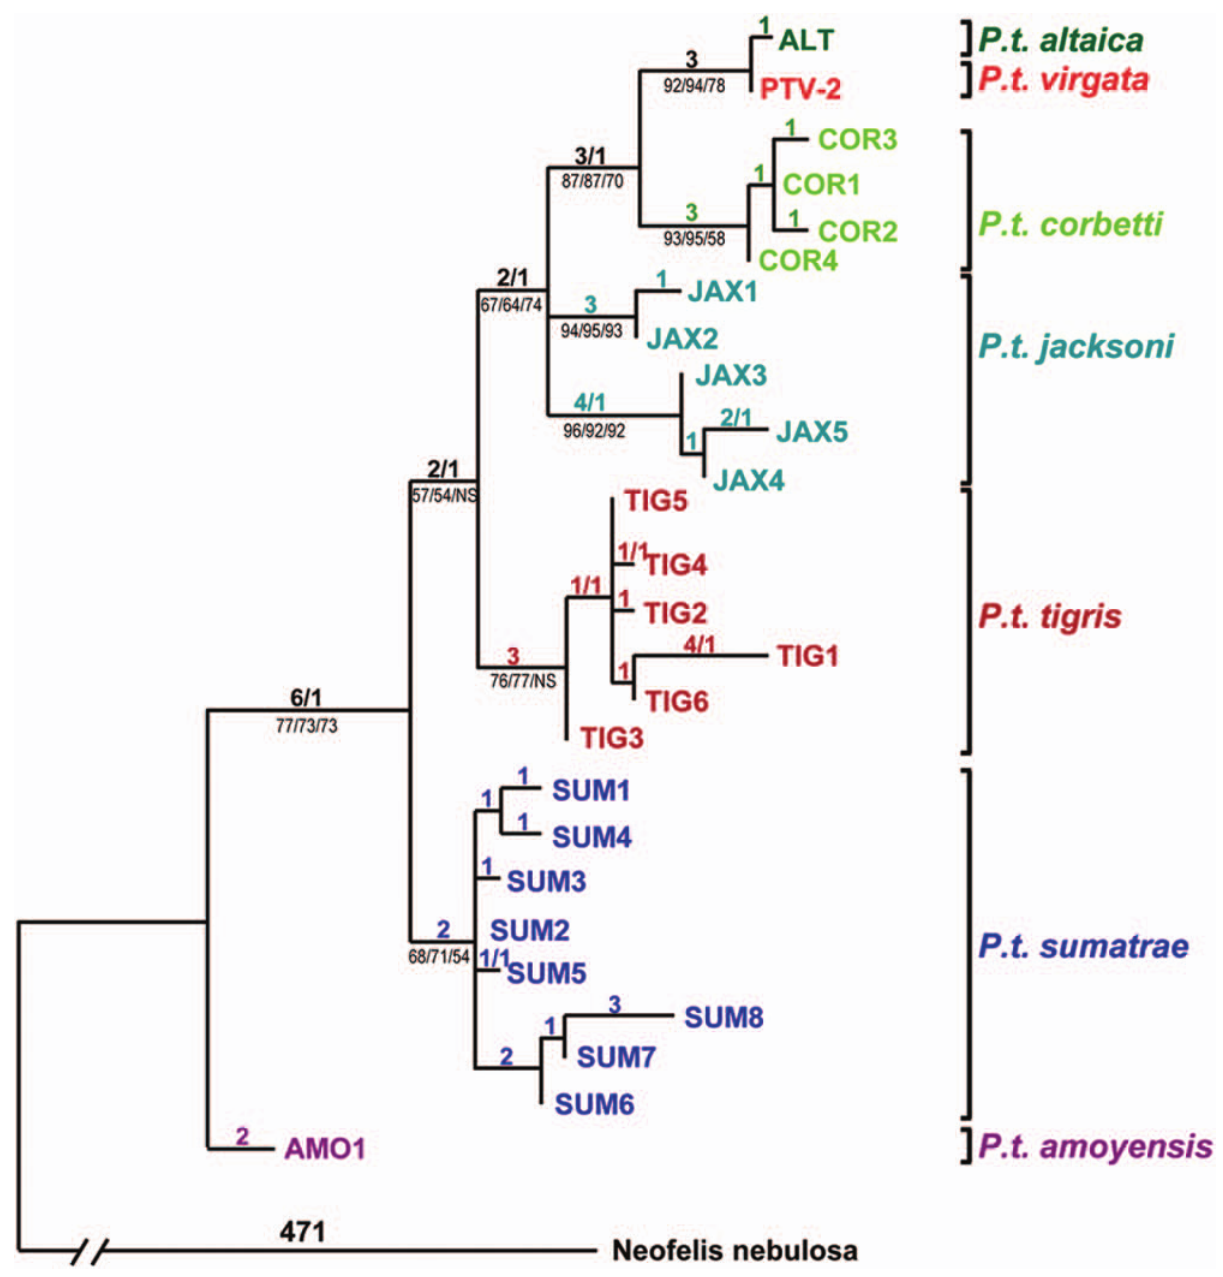
Figure 2. Phylogenetic relationships among tiger mtDNA haplotypes inferred using 4079 bp of concatenated mtDNA sequences (see Table S3). Haplotype designations are color coded by subspecies of the tigers that carried them. PTV-2 is a Caspian tiger ( Panthera tigris virgata ) specimen for which all gene segments attempted (1257 bp) in Caspian tigers were successfully sequenced (see Table S2). Other Caspian tigers produced partial sequences identical to PTV-2. The only exceptions were three individuals, each displaying a single derived nucleotide difference when compared to PTV-2 (found only in that individual and in no other tigers of any subspecies). Likewise, the only mtDNA haplotype carried by Amur or ‘‘Siberian’’ tigers ( P. t. altaica ) proved to be a single derived step away from the haplotype of PTV-2, suggesting a close relationship between the Amur and Caspian tiger subspecies. Tiger haplotypes carried by all but the Caspian subspecies are from a previously published dataset, [11] while a clouded leopard ( Neofelis nebulosa ) sequence (GenBank DQ257669) [14] was used to root the tree. The tree depicted was inferred using maximum parsimony, with the number of steps/homoplasies listed above the branches, while (for major clades) bootstrap percentages are listed below branches for maximum parsimony, maximum likelihood and Neighbour Joining methods. We used full length mtDNA sequences of clouded leopard, leopard and snow leopard to root the tree; all combinations of 1, 2 or 3 outgroups yielded trees with similar topology to the one depicted, with the same basal position for the P. t. amoyensis AMO1 haplotype, and a close relationship between P.t. virgata and P. t. altaica haplotypes. doi:10.1371/journal.pone.0004125.g002 Three distinct geographic routes (A–C in Figure 1) have been the Indian subcontinent south of the Himalayan plateau [4]; B) a previously proposed by which tigers might have colonized the northern route, settling first the Amur region and then traversing Caspian tiger’s historic Central Asian range: A) a southern route, via Siberia westward, north of the Mongolian steppe [1,6,17]; or C) via